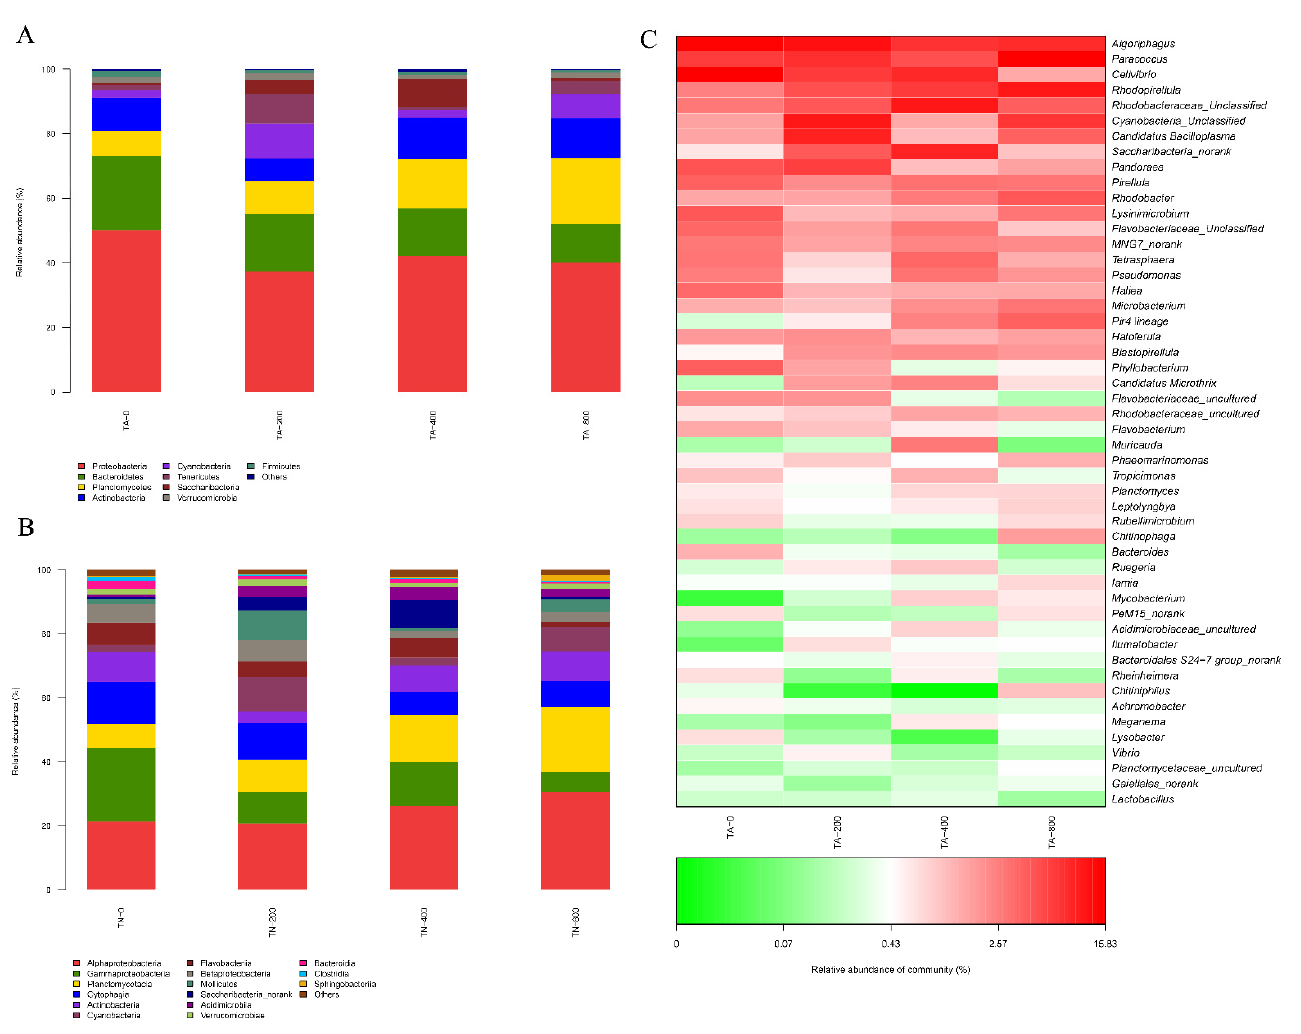
Figure 8. Average relative abundances of dominant bacterial in the intestines of shrimp under different treatments. ( A ) Phyla level, ( B ) classes level, and ( C ) genera level.